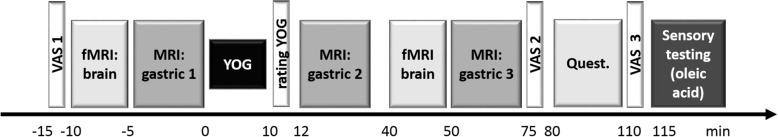
Study design: VAS, visual analog scale; YOG, yogurt.